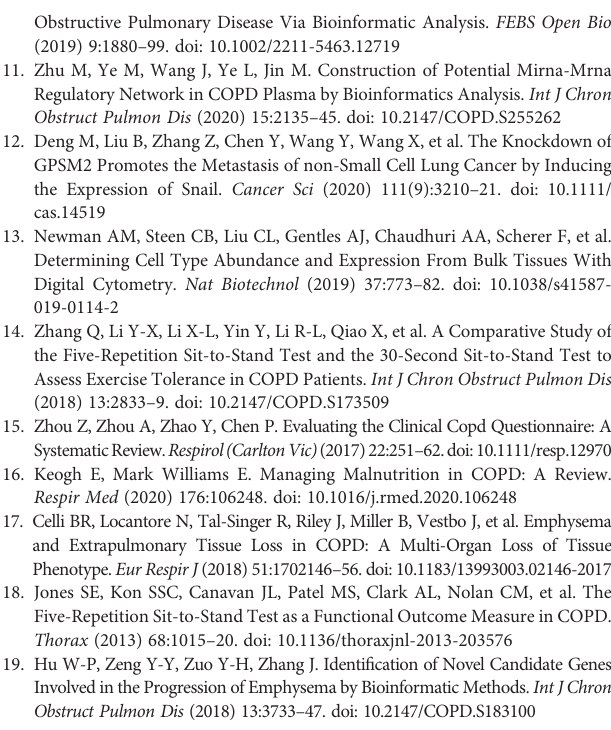
Supplementary Table 1 | GO analysis (biological processes) of the 352 DEGs. Supplementary Table 2 | Pathways were enriched in the smokers group. Supplementary Table 3 | Pathways were enriched in the COPD group. Supplementary Table 4 | Pathways were enriched in the PLA2G7-high